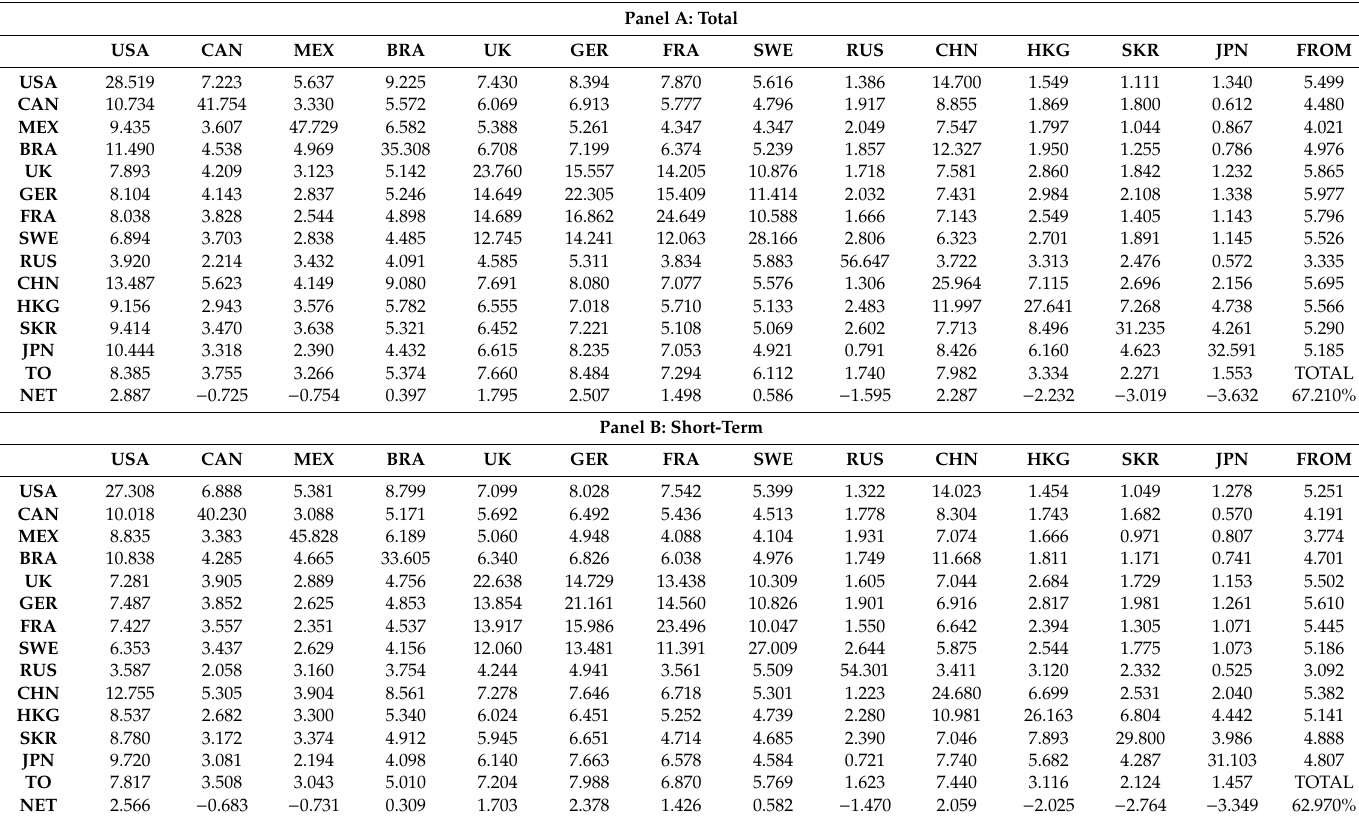
Table A2. Directional shock transmission of Fear